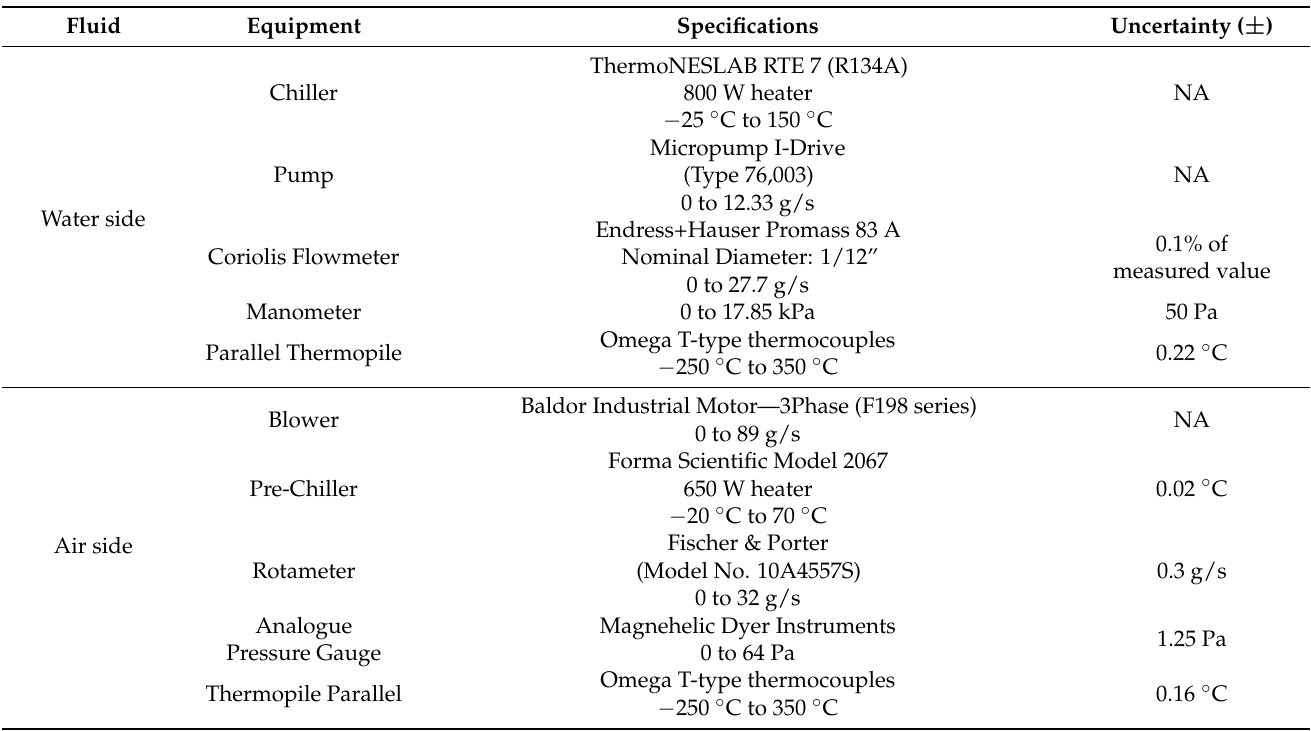
Table 1. Technical specifications of measuring